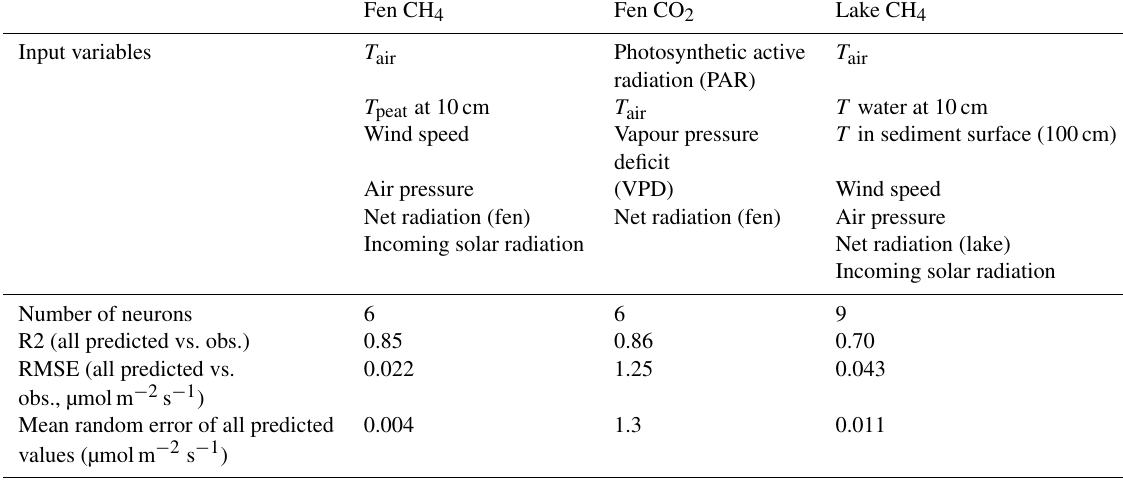
Table B1. Characteristics of the artificial neural networks that were developed for gap filling fen and lake CH 4 fluxes and fen CO 2 fluxes. All networks were developed with one hidden layer and with four fuzzy datasets as additional input to force seasonality. The mean random error is the average of the standard deviation around the modeled flux values for each series (cf. Text S1 in the